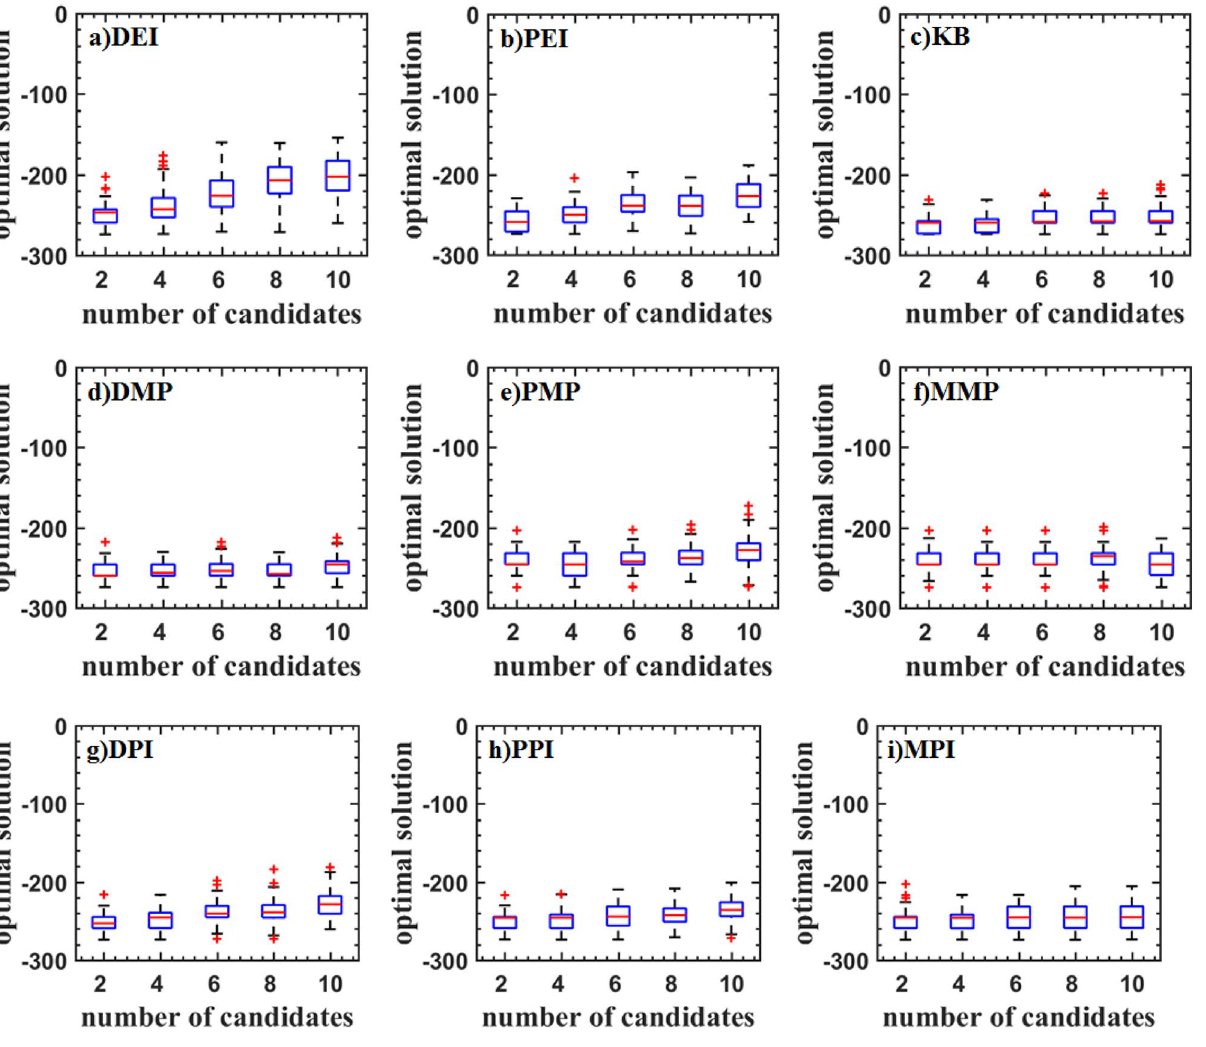
Figure 9. Test problems: StyblinskiTang7